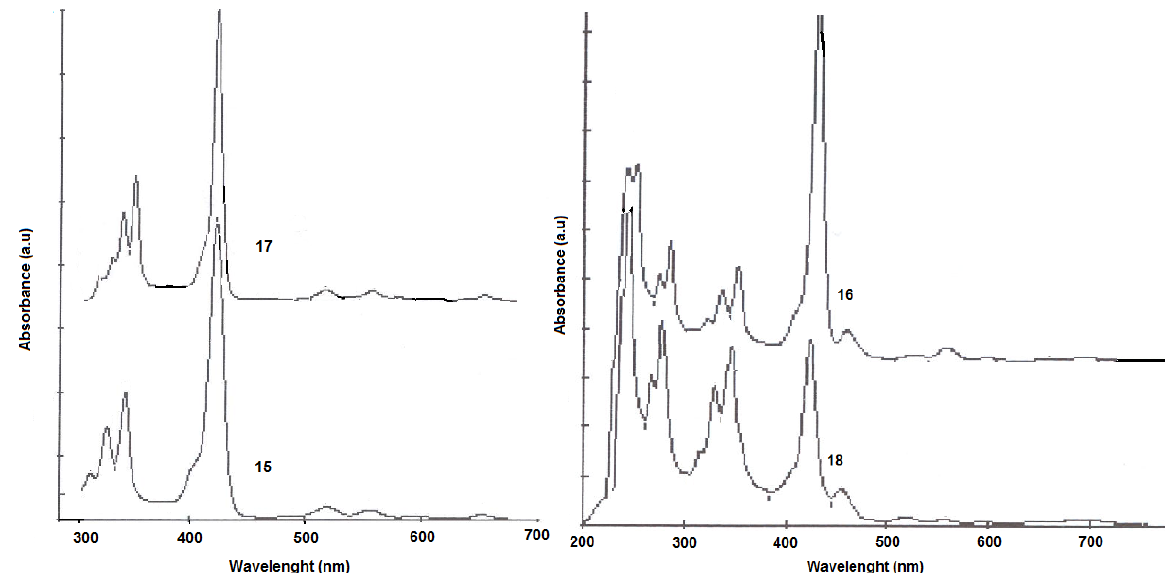
Table 1. UV-vis absorption maxima ( λ